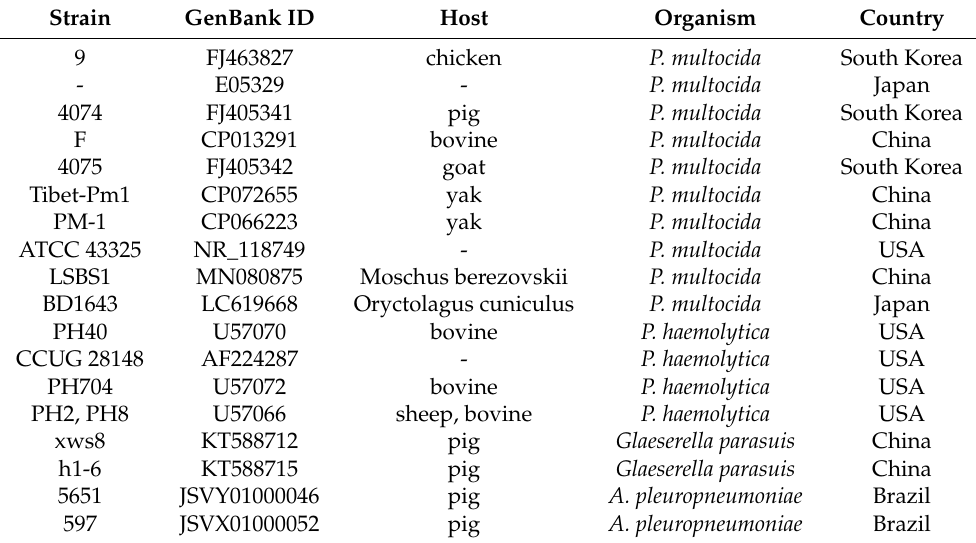
Table 3. The information of the reference bacterial